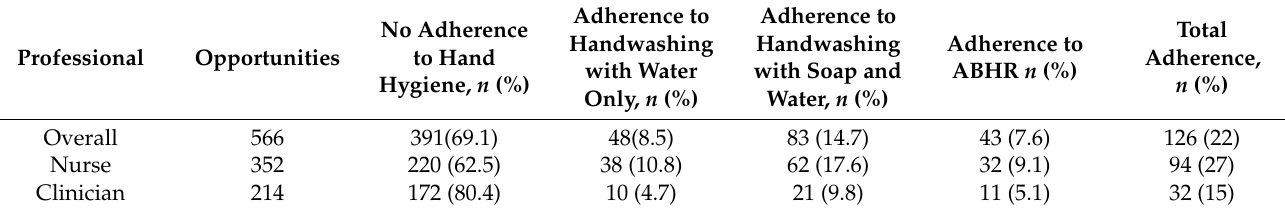
Table 2. Hand hygiene adherence to soap and hand rub among nurses and clinicians.